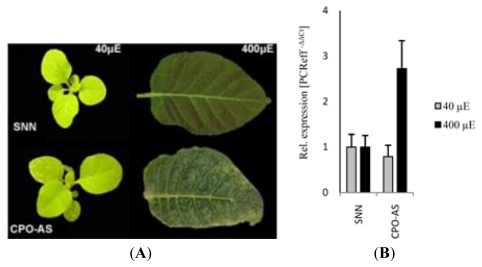
Tobacco NF-YC2 is inducible early in CPO (coproporphyrinogen oxidase)-antisense plants. (A) CPO-antisense RNA expressing plants and control plants were grown under low light condition (left panels) before adult plants were transferred to high light. After exposure to high light, CPO-antisense plants show leaf necrosis; (B) Quantitative RT-PCR analysis of NtNF-YC2 transcripts of CPO antisense and SNN wild-type plants before and 6 h after transfer from low (40 μM photon m−2·s−1) to high light intensities (400 μM photon m−2·s−1). (A) (B)